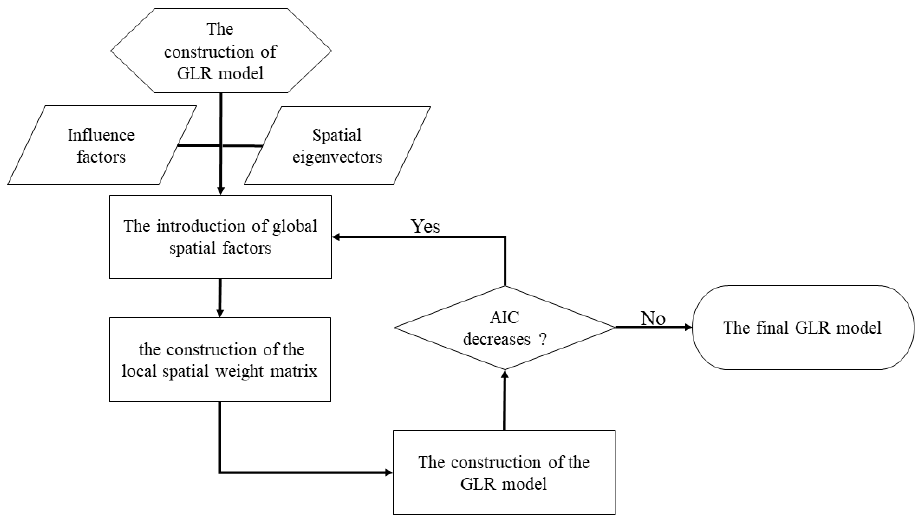
Figure 2. The workflow of the construction of the GLR